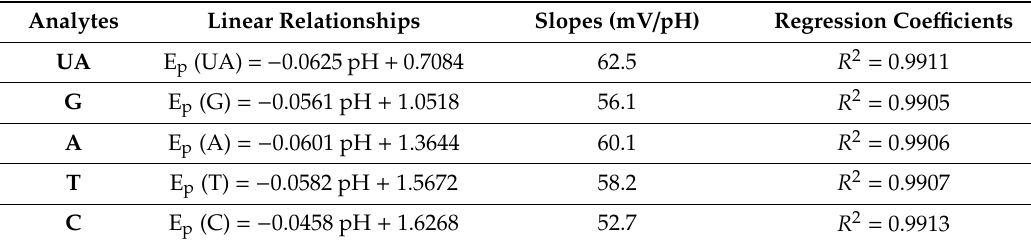
Figure 4. Relationship between pH and E p for the simultaneous electrochemical detection of all four DNA bases in the presence of UA using GCE/GO ‐ MWCNT ‐ CHT. Table 1. A summary of the results for the linear dependence of E p on pH for UA and DNA bases using GCE/GO ‐ MWCNT ‐ CHT.